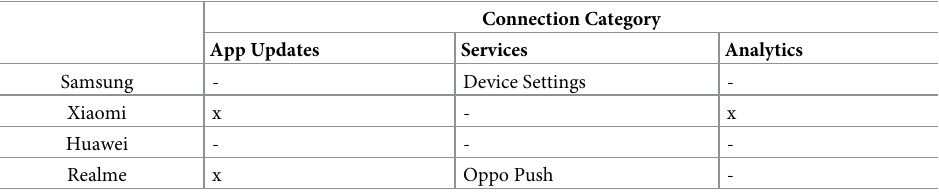
Table 5. Connection categories sending list of installed apps.